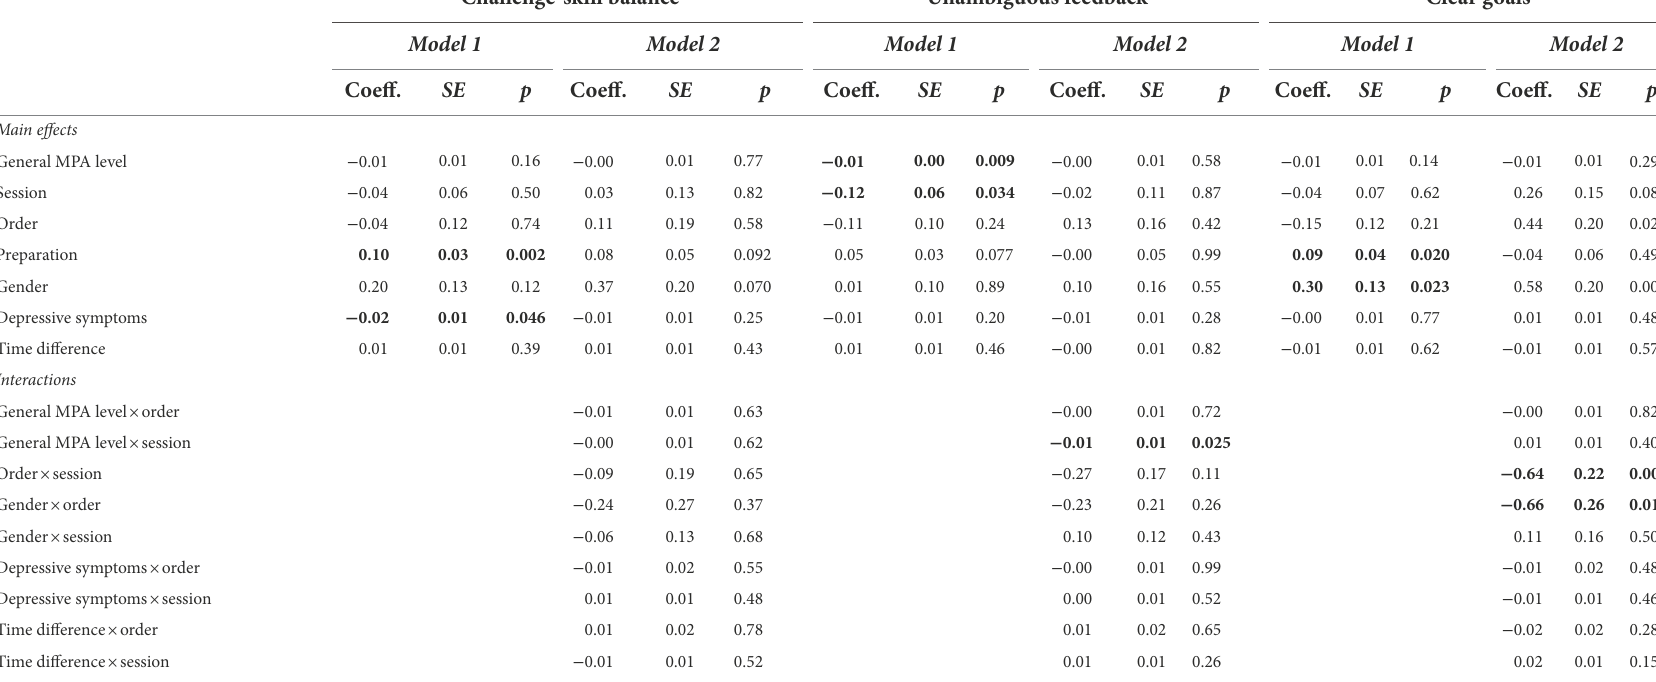
TABLE 3 Estimated linear mixed models for the dimensions “challenge-skill balance,” “unambiguous feedback,” and “clear